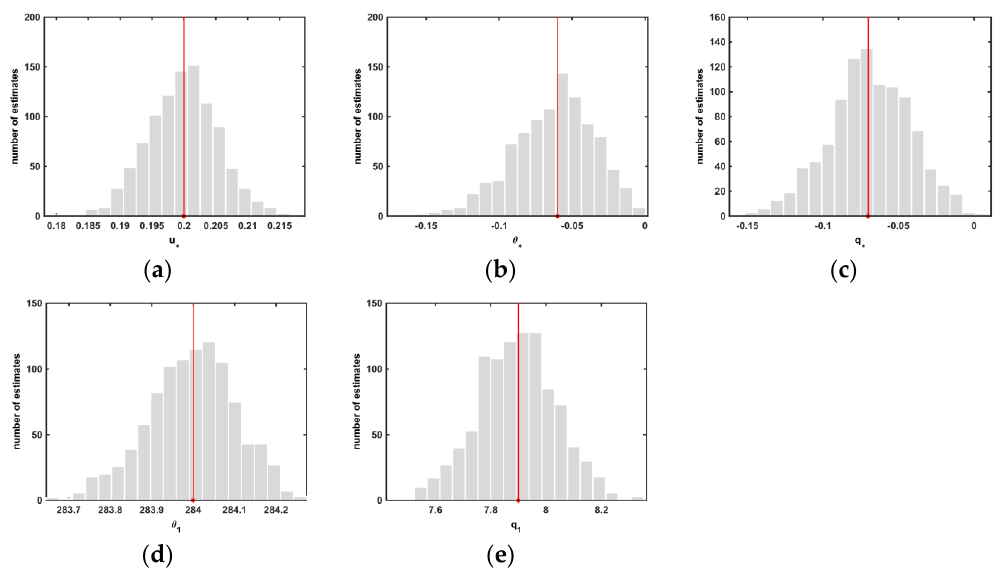
Figure 5. Histograms of estimates for ( a ) 𝑢 ∗ (m·s −1 ); ( b ) 𝜃 ∗ (K); ( c ) 𝑞 ∗ (g·Kg −1 ); ( d ) 𝜃 ̅ 1 (K); and ( e ) 𝑞̅ 1 (g·kg −1 ) estimated from the synthetic sample datasets.